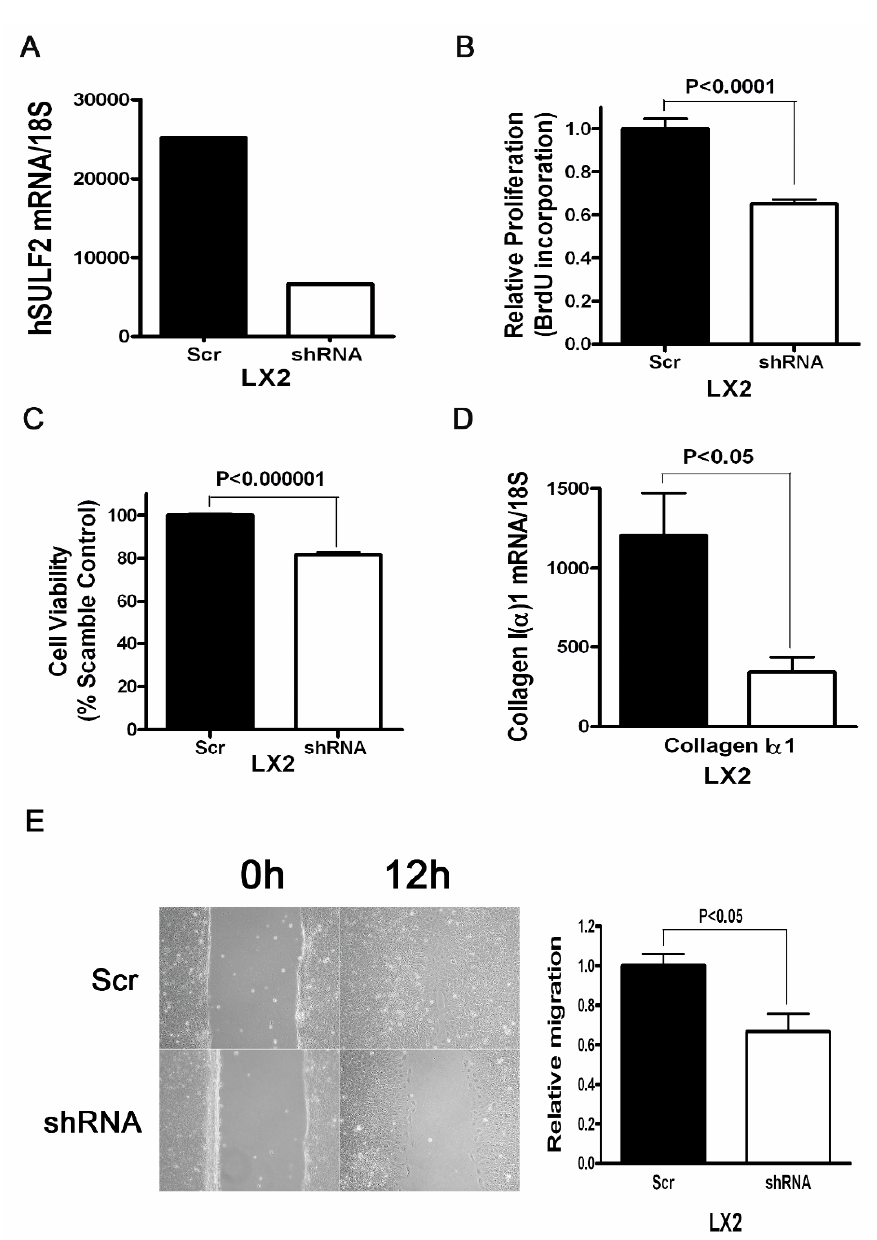
Figure 4. The effect of SULF2 on human hepatic stellate cells. ( A ) Plasmid constructs expressing an shRNA targeting the SULF2 mRNA or the empty vector (scrambled shRNA) plasmid pSS-H1p were stably transfected into human hepatic stellate cells (HSCs), which express high levels of SULF2 mRNA. SULF2 mRNA levels were quantitated by real-time RT-PCR in HSC scrambled and the SULF2 shRNA clone. SULF2 mRNA levels were significantly suppressed by the shRNA plasmid. ( B ) BrdU incorporation in HSCs transfected with Scr vs. SULF2 shRNA. ( C ) MTT assay in HSCs transfected with Scr vs. SULF2 shRNA. ( D ) The levels of collagen I( α )1 mRNA in HSCs. ( E ) Scratch wounds were induced in confluent cell culture monolayers with a 200 μ L pipette tip; photomicrographs of the wounds were taken at 0 and 12 h post induction. Relative migration of the wound edge was quantitated. We observed a significantly decreased rate of migration in HSC transfected with shRNA relative to HSC transfected with the scrambled shRNA plasmid. Data in each experiment are presented as the mean ± standard deviation of triplicates from one representative experiment.